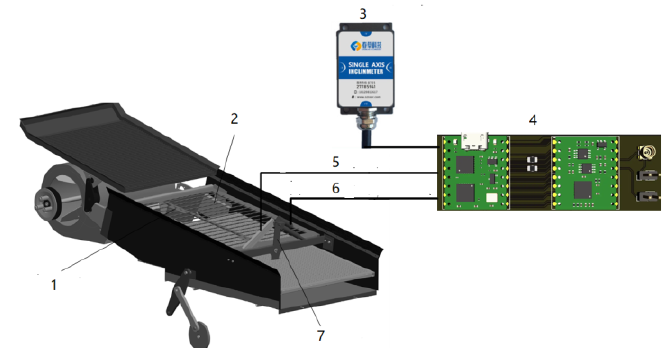
Figure 1. Structural composition of automatic leveling system. 1: rotating shaft; 2: screen; 3: inclina- tion sensor; 4: controller; 5: distance sensor; 6: electric cylinder; 7: swing rod.